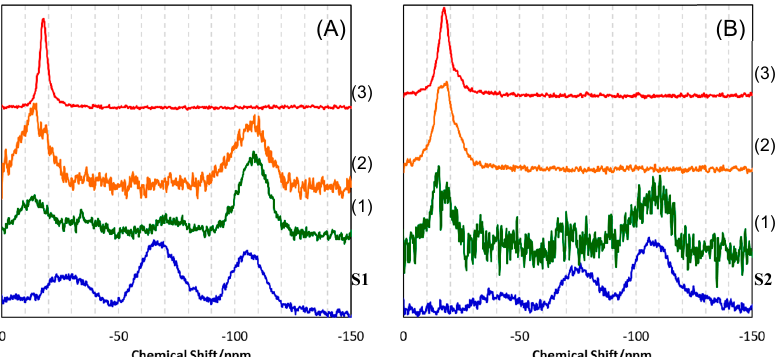
Figure 10. 29 Si MAS NMR spectra for SQ-derived S1 and S2 synthesized by pyrolysis at 800 °C, and those after subsequent heat treatment at (1) 1400, (2) 1600 and (3) 1800 °C. Polymeric precursors: ( A ) VH-SQ and ( B ) St-H-SQ.